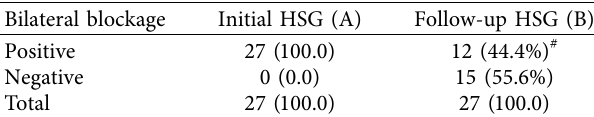
Table 3: True positive HSG diagnosis (bilateral tubal